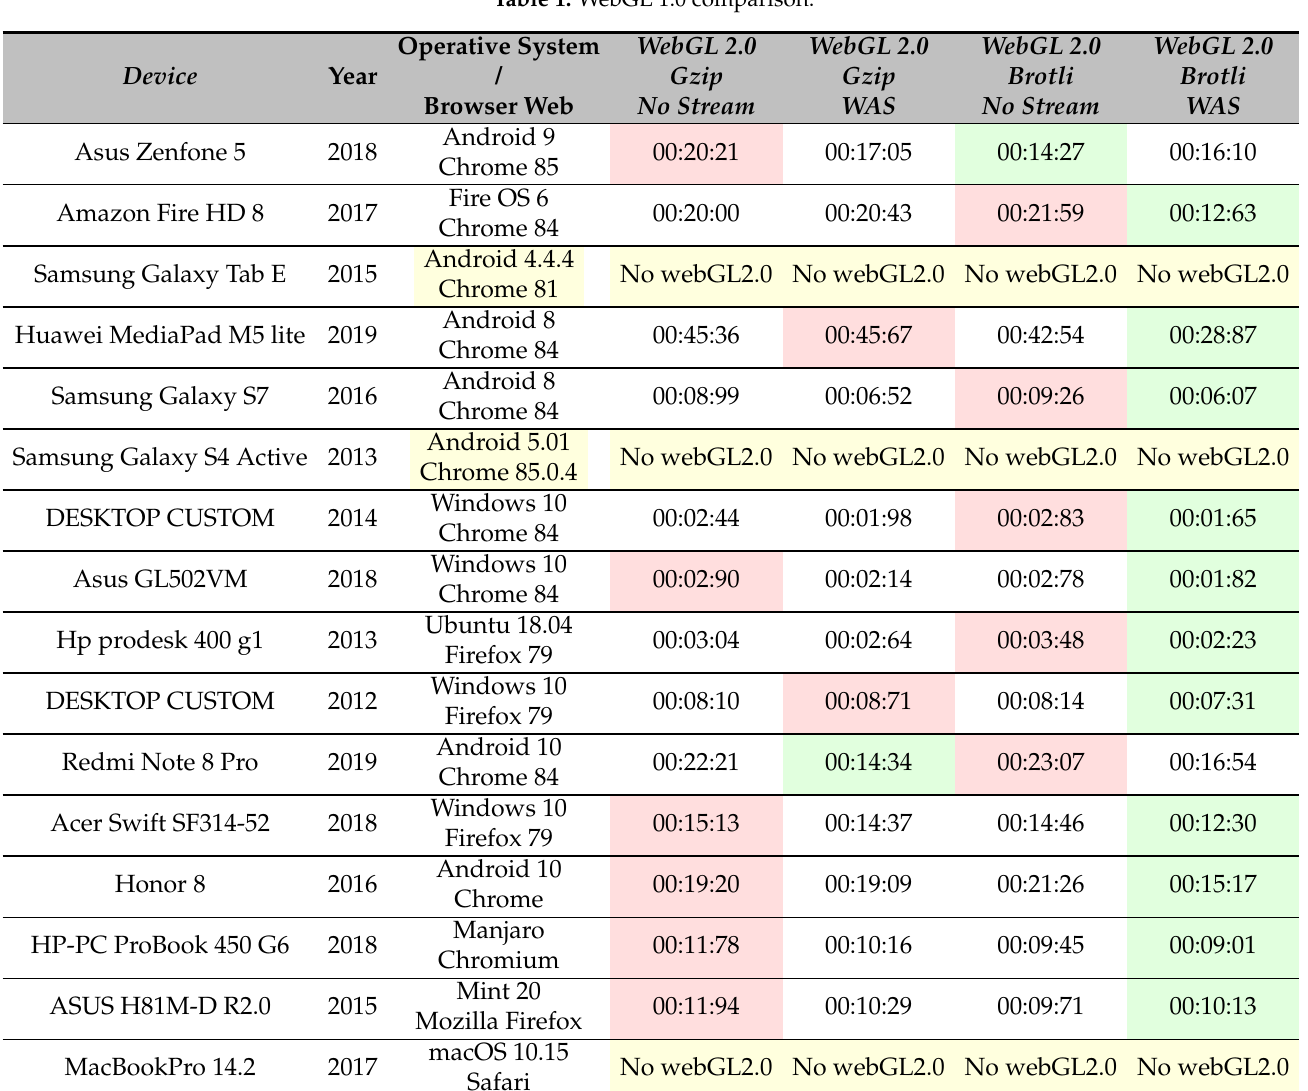
Table 1. WebGL 1.0